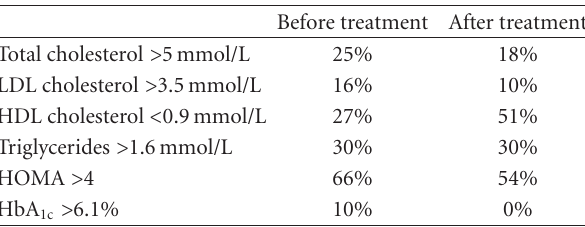
Table 3: Patients at risk before and after participation in the obesity intervention